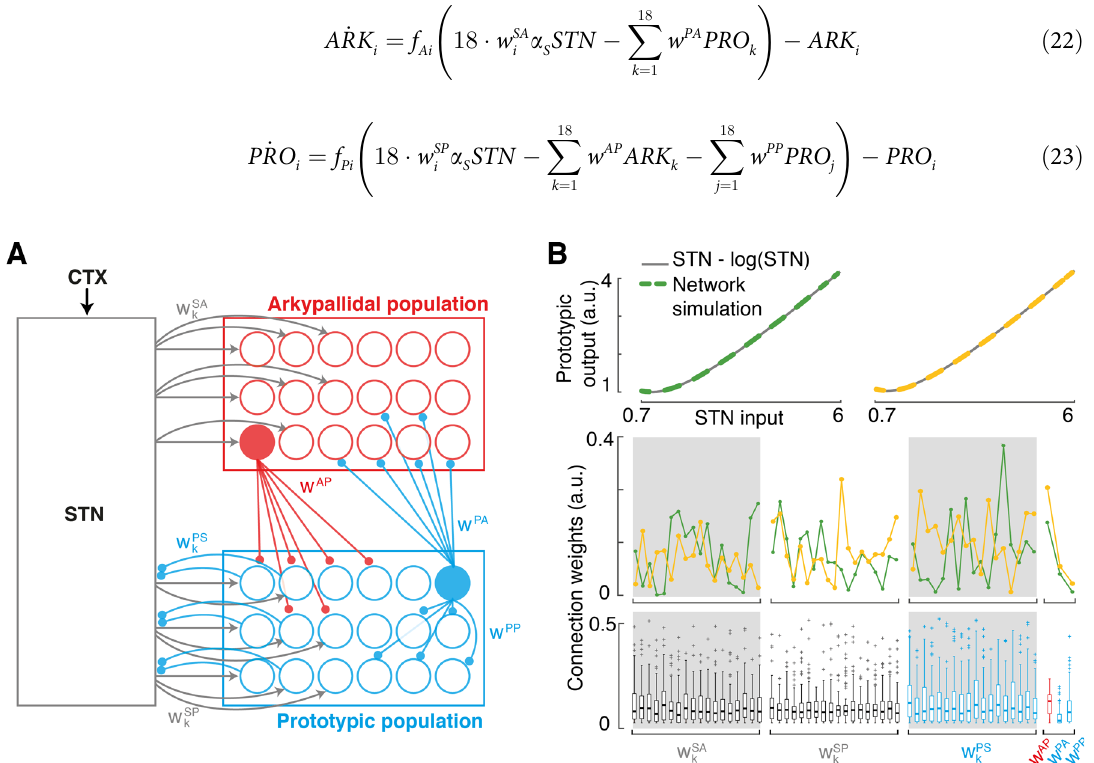
Fig 6. Computational model of STN-GPe network. (A) Architecture of the model including all 18 prototypic and arkypallidal neurons recorded experimentally, and connections within GPe and with STN. w iXY denotes the strength of connections between population X and Y . Sub-indices indicate the individual neuron associated with each weight. Inner GPe weights linking arkypallidal and prototypic neurons are assumed identical for all connections, hence represented by a single value. (B) Illustrative examples of inhibition sent from GPe to STN i.e. yellow and green), and comparison with the desired function STN – log STN throughout the input range considered ([0.7 – 6]). Middle plot shows two sets of weight parameters corresponding to the top display, and the bottom display shows the range of weight parameters found in 100 runs. Weights for each population are organised from the most linear neuron ’ s to the most logarithmic neuron ’ s (left to right), highlighting the lack of preferential connections to linear or logarithmic